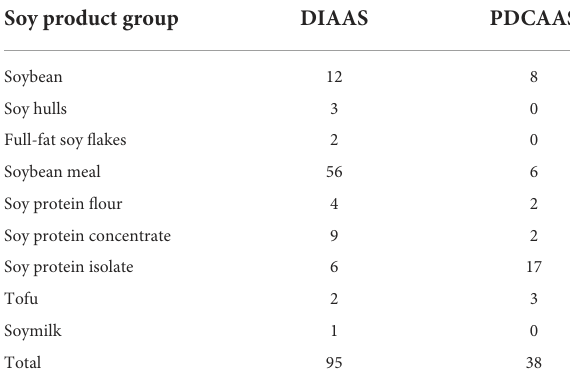
TABLE 1 Overview of datasets by soy product group and protein quality